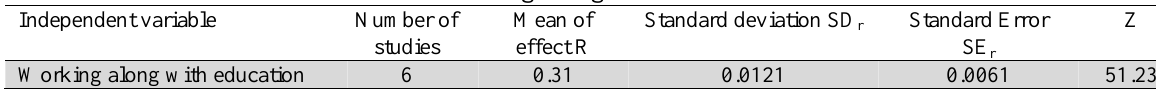
Mean of Standard deviation SD r studies effect R